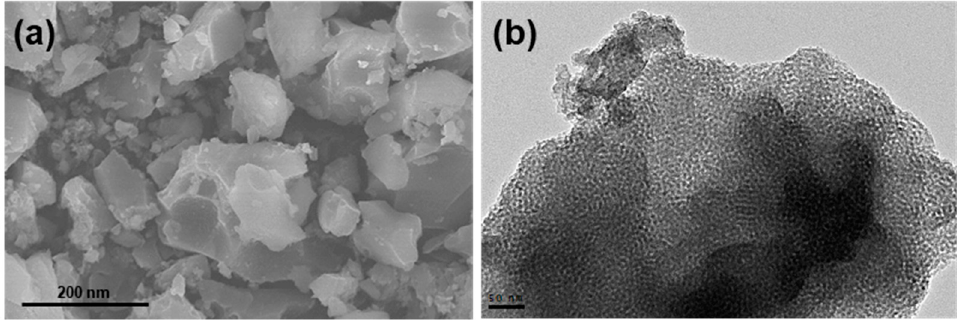
Figure 4. Morphological analysis ( a ) SEM; and ( b ) TEM images of the MSH@MA